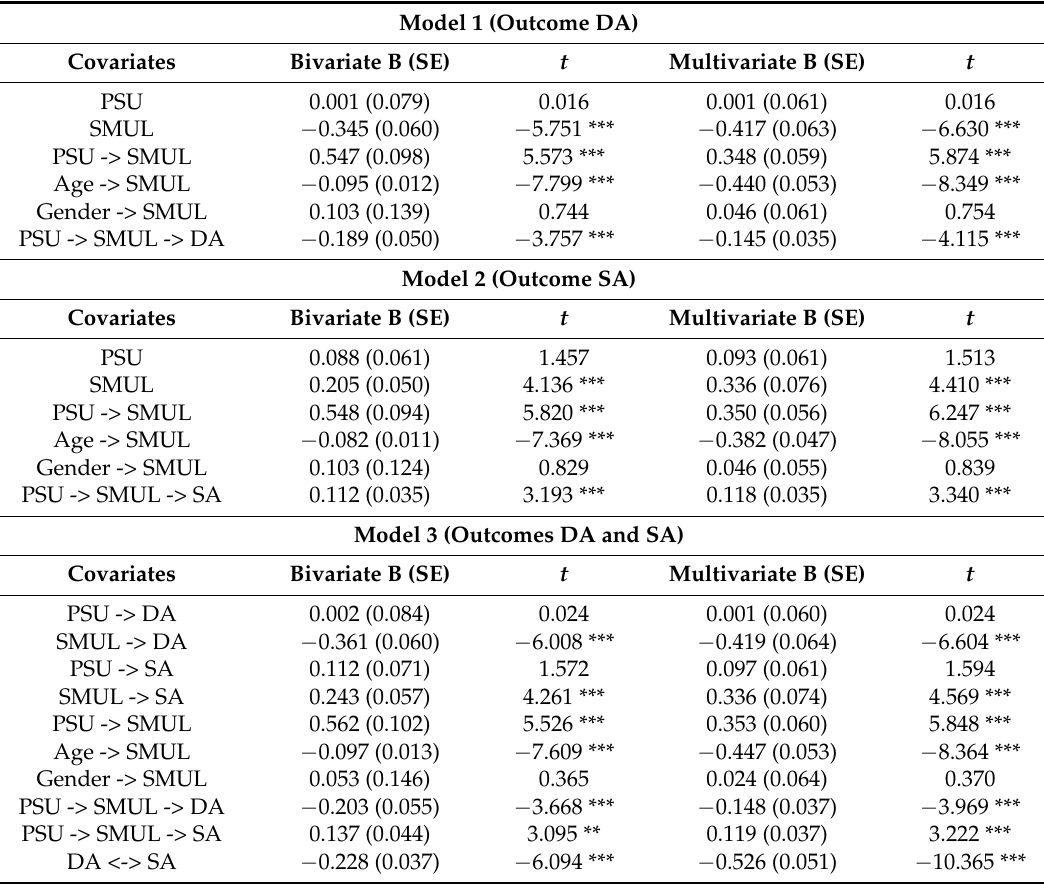
Table 2. The results of mediation